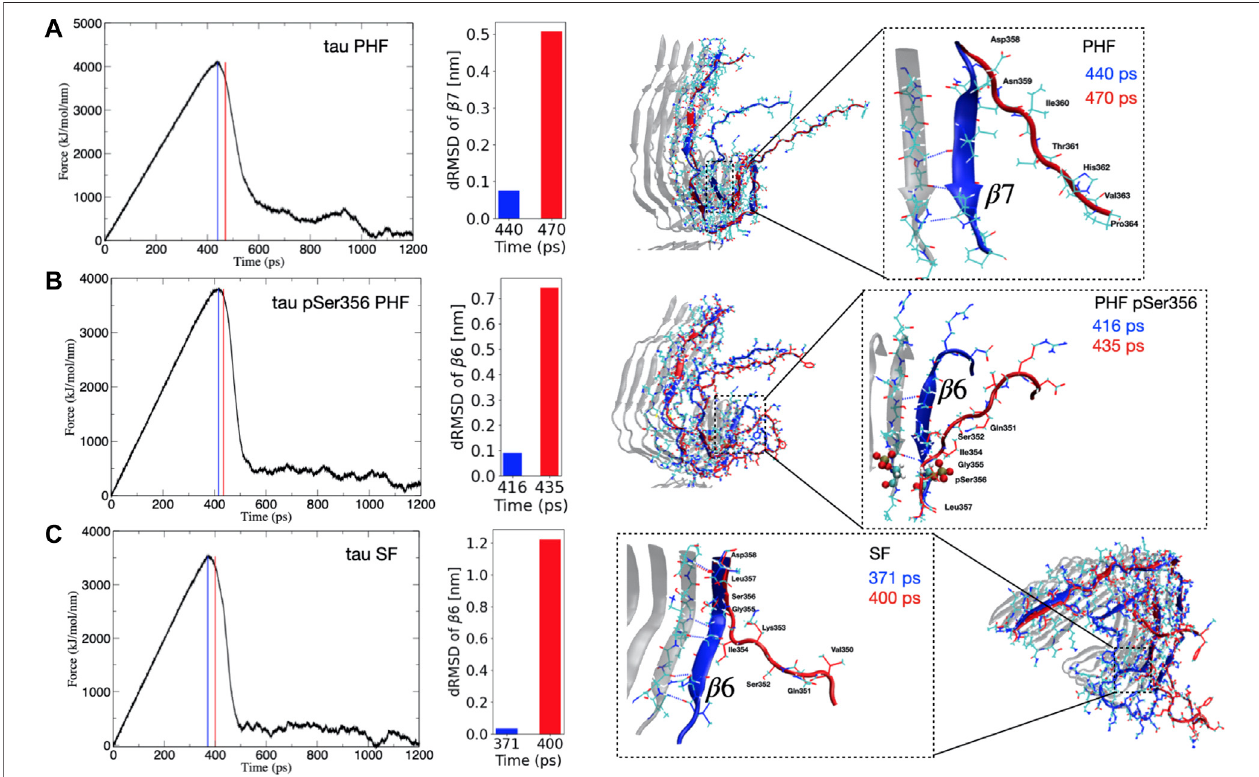
FIGURE 2 | (Left) Time evolution of the force during SMD simulations for the (A) PHF, (B) phosphorylated pSer356 PHF, and (C) SF tau proto fi brils. The blue verticalline(anddepictedbluepeptidestructureontheright)correspondstothestructureatthemaximumforce.Theverticalredline(anddepictedredpeptidestructure on the right) correspond to a representative frame just after this maximum force has been reached and the force curve begins to decrease. This corresponds to a major structuraltransitionwhereimportanthydrogenbondshavebeenbrokenduringdissociation. (Right) Theinsethighlightstheregionofsecondarystructurelossthat occurs between the point of maximum force (blue) and immediately after the force curve begins to decrease (red). For PHF (A) this event correlates with loss of the β 7 secondary structure as indicated by the increase in the dRMSD value for this structure during this time window. For the PHF-pSer356 (B) and SF (C) the adjacent β 6 region unfolds during the time window with corresponding increase in the dRMSD with respect to the reference β 6